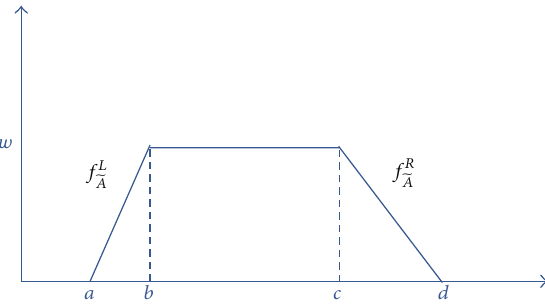
Figure 3: Memberships function of a trapezoidal fuzzy